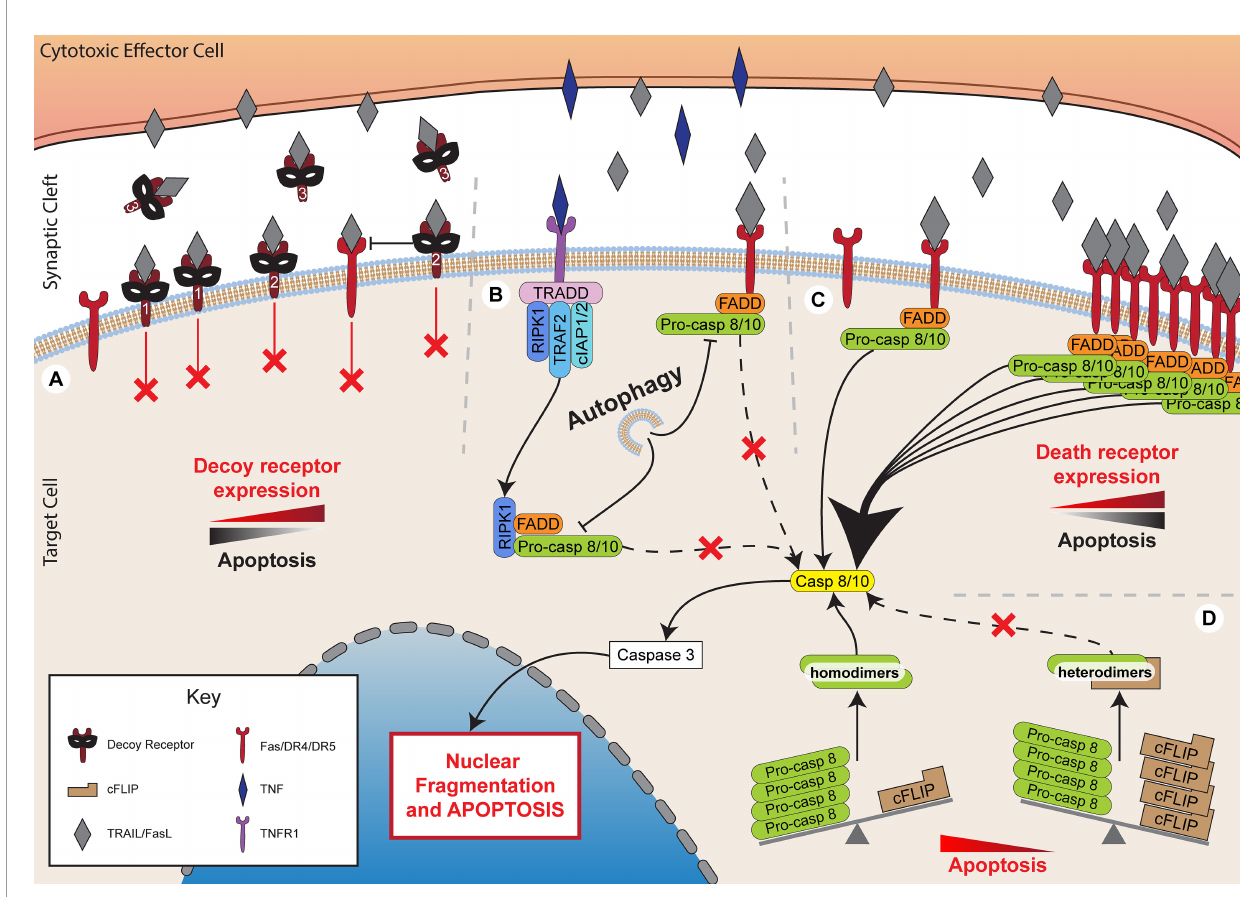
FIGURE 3 | Inhibiting death receptor-mediated killing. Death receptor-mediated killing is a critical method of lymphocyte cytotoxicity. However, target cells have developed multiple mechanisms to inhibit the effectiveness of these processes. (A) Expression of decoy receptors, including membrane bound decoy receptors 1 and 2 that lack functional death domains, thereby preventing signalling while sequestering TRAIL. Decoy receptor 2 also inhibits death receptor 5, preventing death receptor 4 recruitment and DISC formation. Decoy receptor 3 is soluble and binds to FasL preventing it acting upon target cell Fas. (B) Autophagy inhibits FADD- dependent caspase-8 activation. (C) Decreased expression of death receptors, such as Fas, DR4 and DR5 inhibits apoptotic pathways. (D) Increased expression of cFLIP sequesters pro-caspase 8 into heterodimers to prevent its cleavage to caspase 8 and the subsequent activation of apoptotic